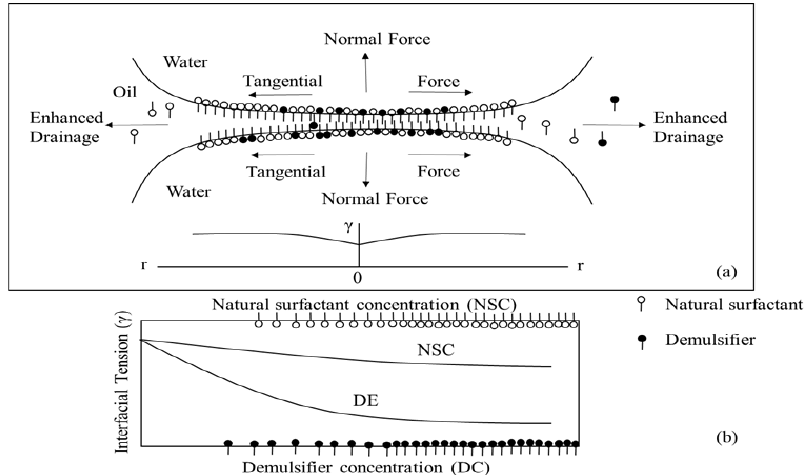
Figure 9. ( a ) The film drainage in the presence of demulsifier; ( b ) Influence of concentration of natural surfactant and demulsifier on crude oil and water interfacial tension. Reproduced with permission from A. Bhardwaj et al., 1994 (ref. [176]). Copyright 1994 American Chemical Society.